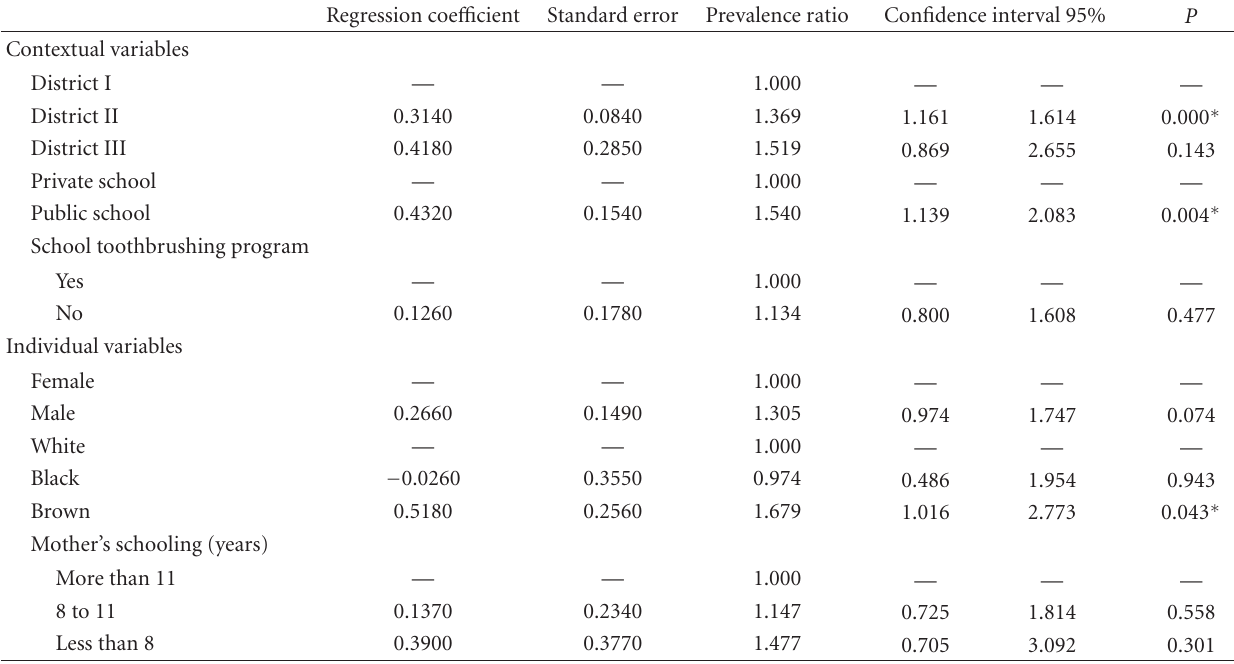
Table 2: Results of nonadjusted multilevel analysis model of poisson log-linear regression for prevalence of periodontal condition (calculus and/or bleeding). Goiania, Brazil,